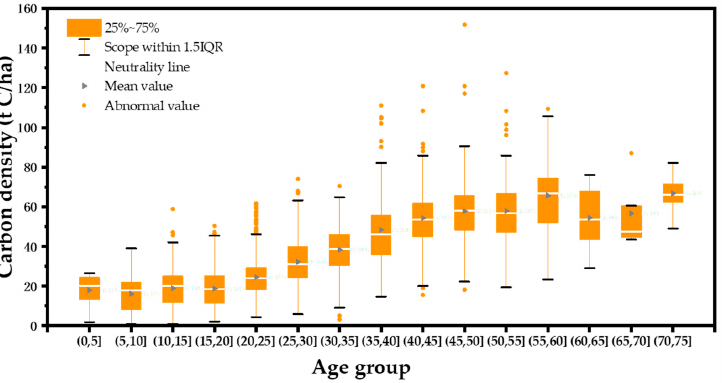
Figure 4. Box-and-whisker plot for forests carbon density by age in Lushan City. The figure shows the median, 25th and 75th percentile, mean (triangles), range, and extreme values outside the range (the proportion of the interquartile range past the low and high quartiles is 1.5, points outside this range will be identified as outliers).